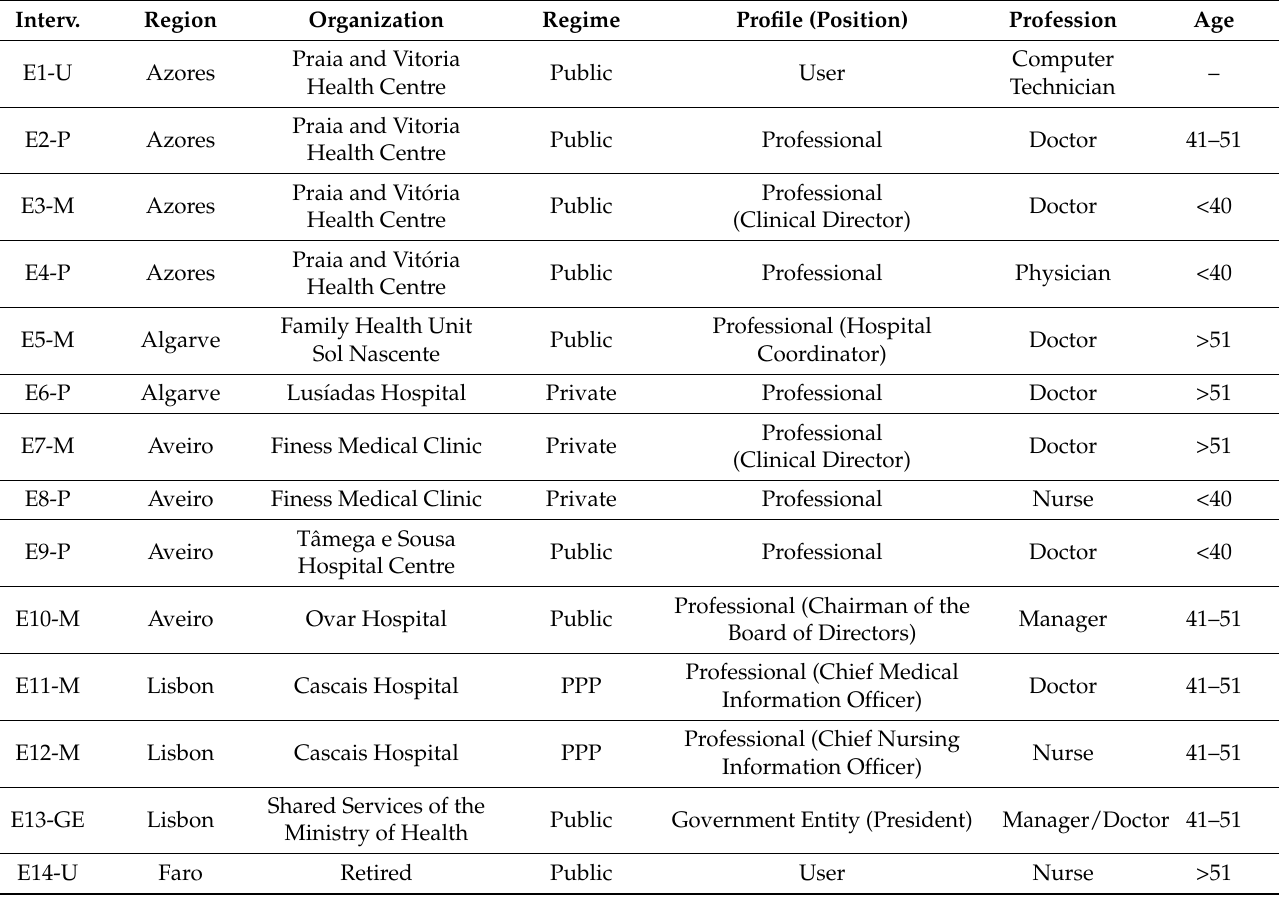
Table 1. Characterization of the sample profile of